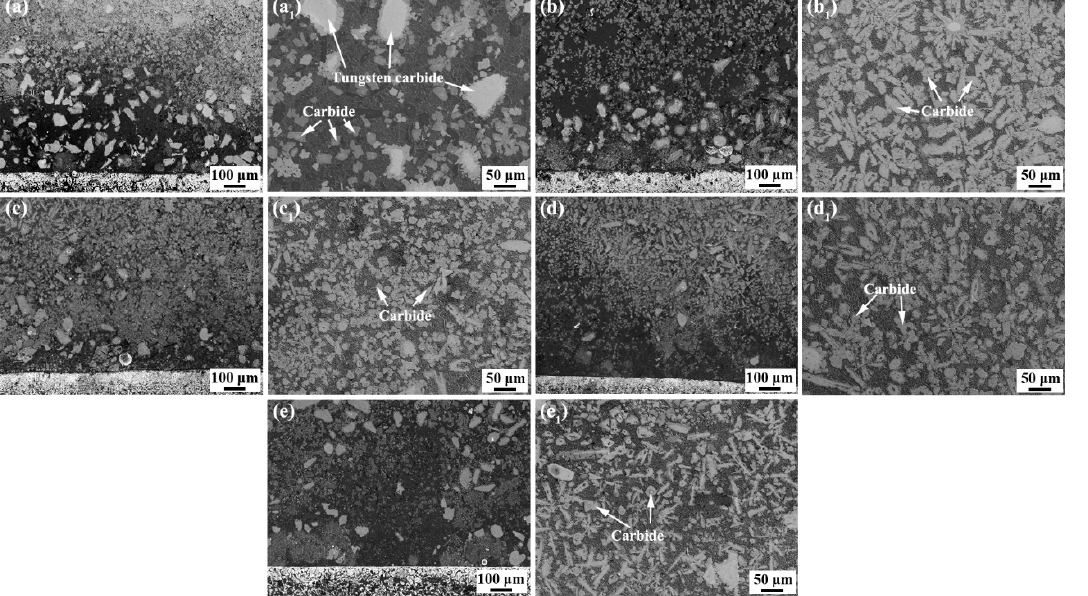
Figure 1. Microstructure in cross section of Ni-based tungsten carbide cladding layer under different CeO 2 contents: ( a , a 1 ) 0 wt.%CeO 2 , ( b , b 1 ) 0.1 wt.% CeO 2 , ( c , c 1 ) 0.2 wt.% CeO 2 , ( d , d 1 ) 0.5 wt.% CeO 2 , and ( e , e 1 ) 1.0 wt.% CeO 2 .